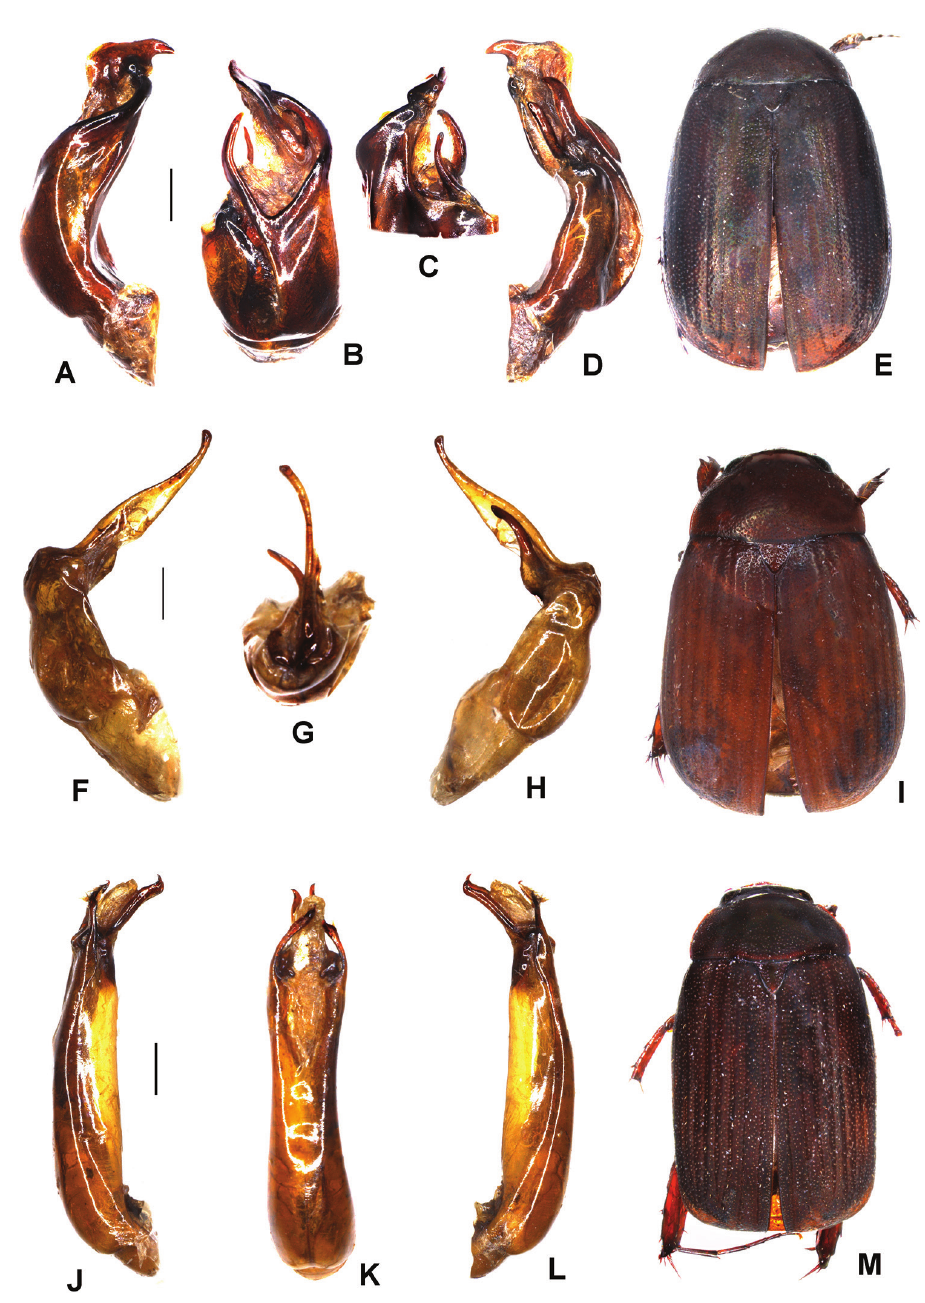
Figure 1. A–E Maladera alloservitrita sp. n. (holotype) F–I M. kolasibensis sp. n. (holotype) J–M M. mizoramensis sp. n. (holotype) A, F, J aedeagus, left side lateral view D, H, L Aedeagus, right side lateral view B, G parameres, dorsal view K phallobase, dorsal view. C parameres, ventral view E, I, M habitus. Scale bar: 0.5 mm. Habitus not to